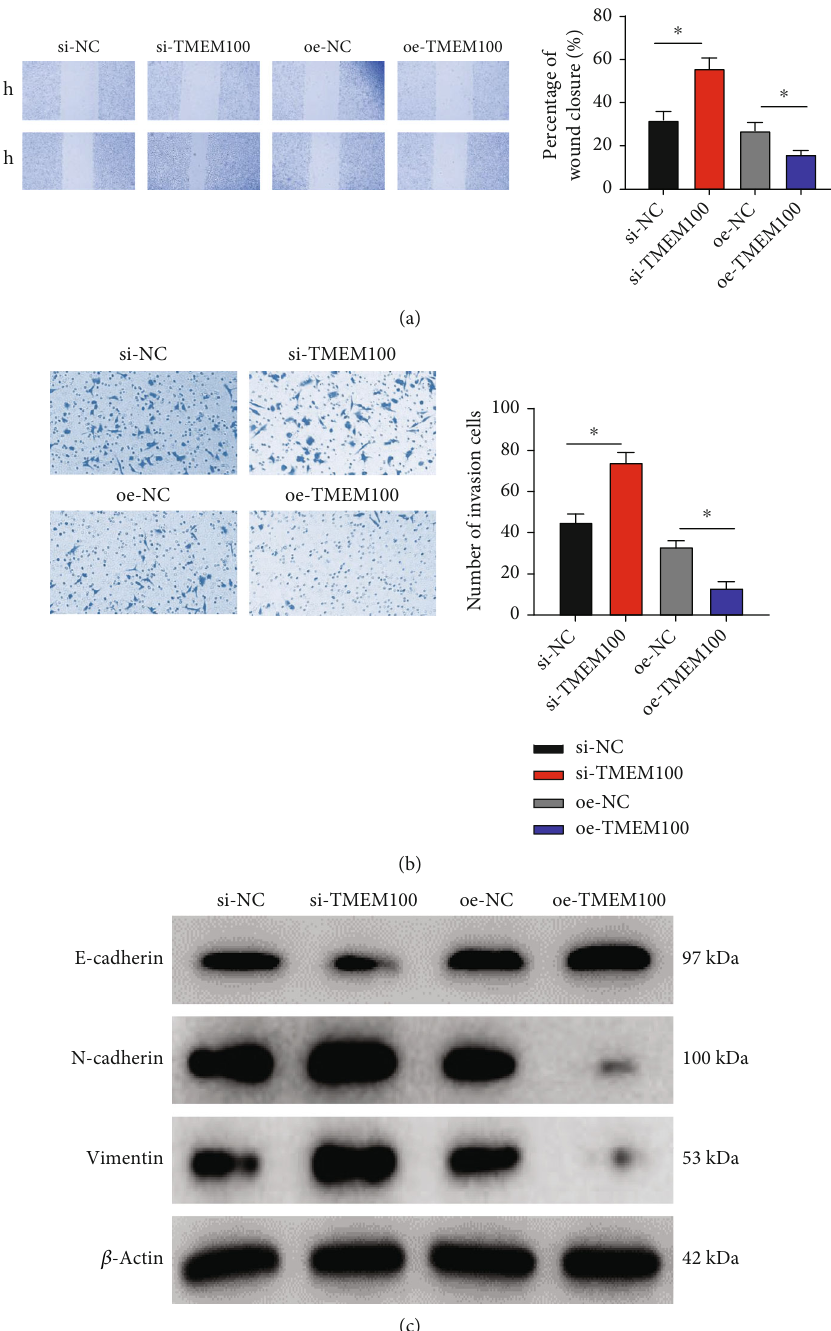
Figure 3: TMEM100 restrains the migration and invasion of NCI-H498 cells. (a) Scratch healing assay detected the migration of NCI-H498 cells upon TMEM100 silencing and overexpression. (b) Transwell assay assessed invasion of NCI-H498 cells upon TMEM100 silencing and overexpression. (c) Western blot tested the e ff ect of TMEM100 on EMT of NCI-H498 cells. ∗ p < 0 : 05